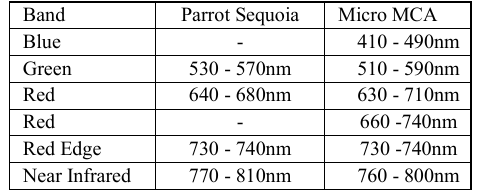
Table 1. Wavelength specifications of the UAV sensors